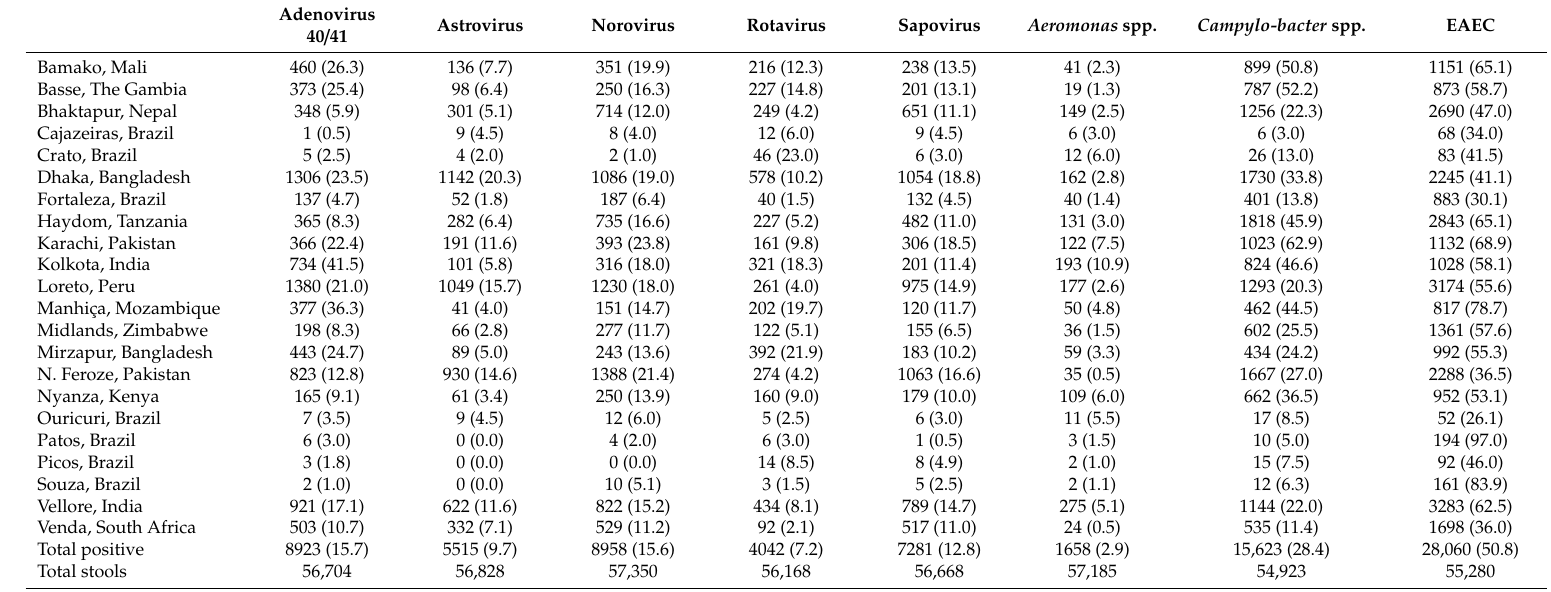
Table 1. Number and percentages (%) of stool samples from children aged 0–59 months that were positive for di ff erent species of enteropathogens by qPCR in 22 study sites and overall (includes both cases and controls from the Global Enteric Multicenter Study (GEMS)1 and